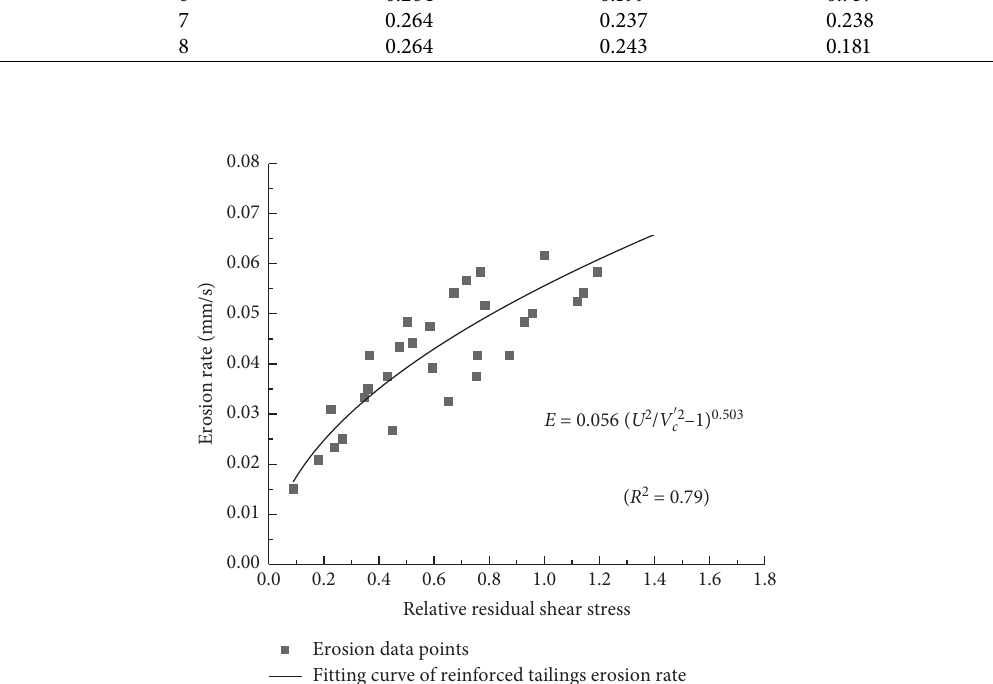
Figure 8: Relationship between erosion rate of reinforced tailings and relative residual shear